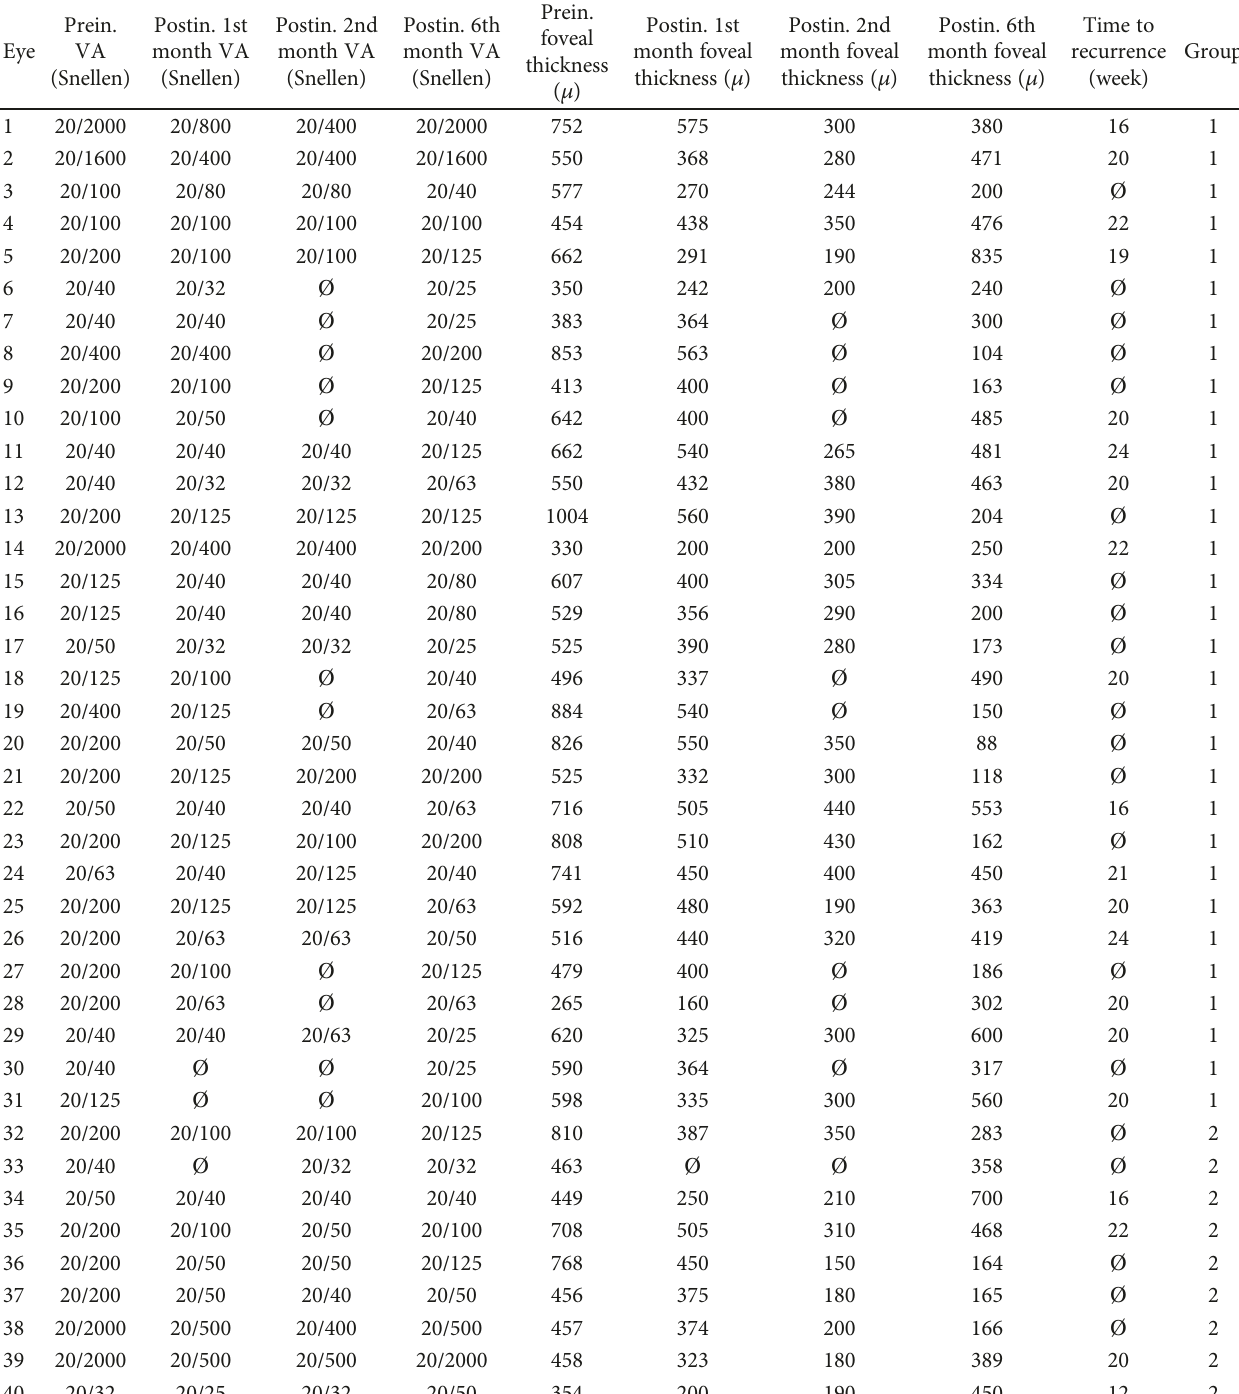
Table 2: Results of the current